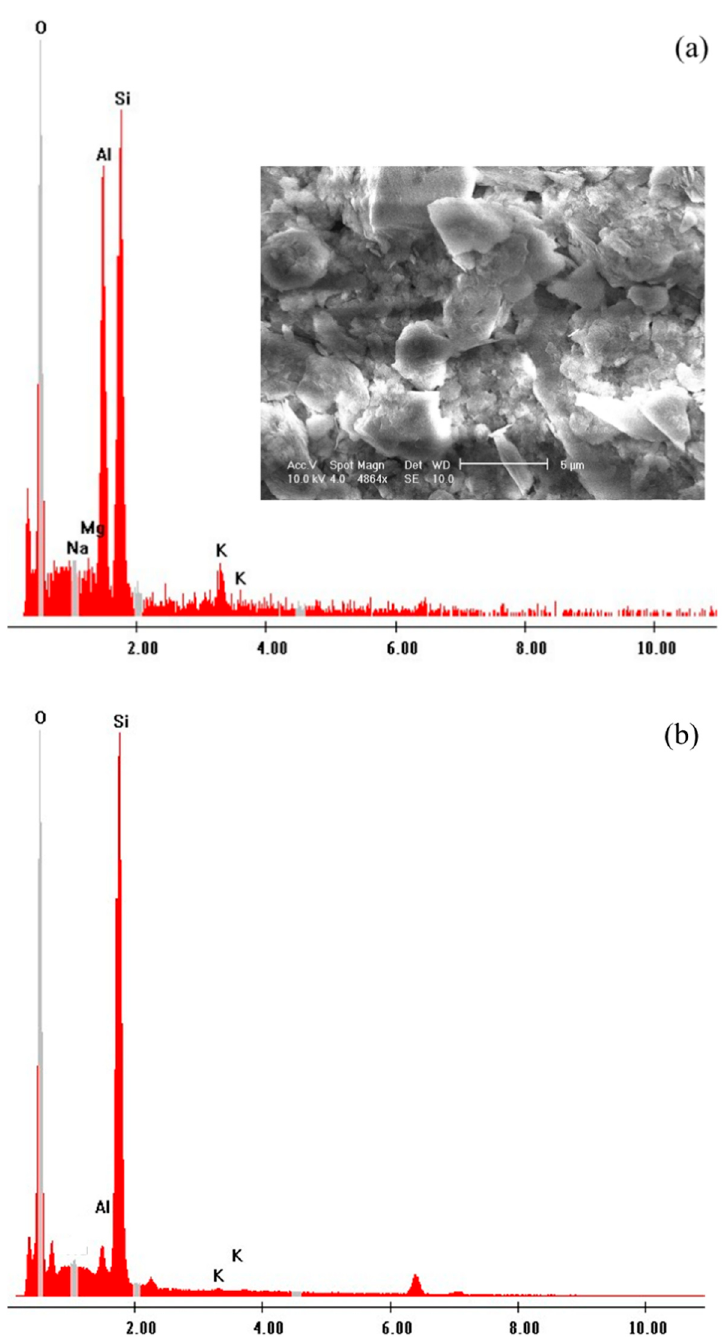
Figure 1. Typical results of energy dispersive spectroscopy (EDS) analysis on ( a ) pure montmorillonite (smectite-clay group) and ( b ) LBS grain.